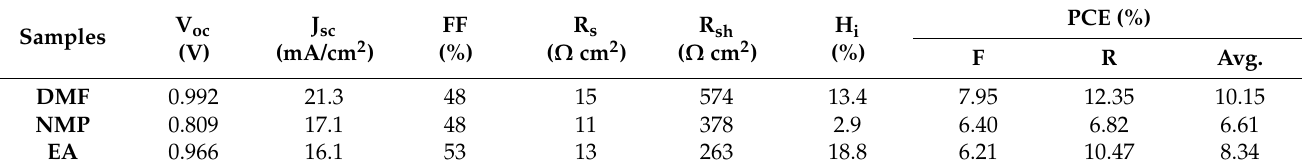
Table 3. Photovoltaic characteristics represented as average values of 16 solar cells for each composition.